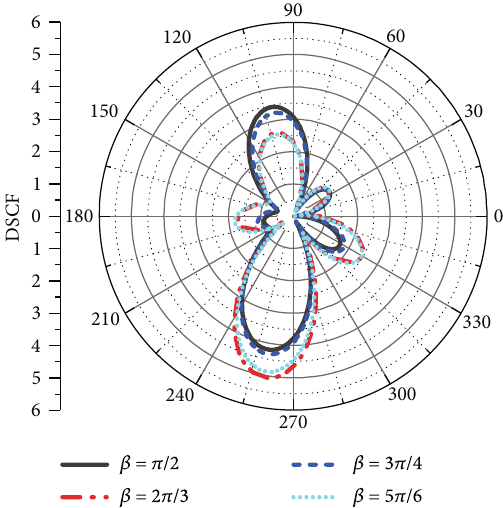
Figure 12: DSCF distribution of the circular hole with di ff erent β ( r / r 2 = 0 : 5 ).